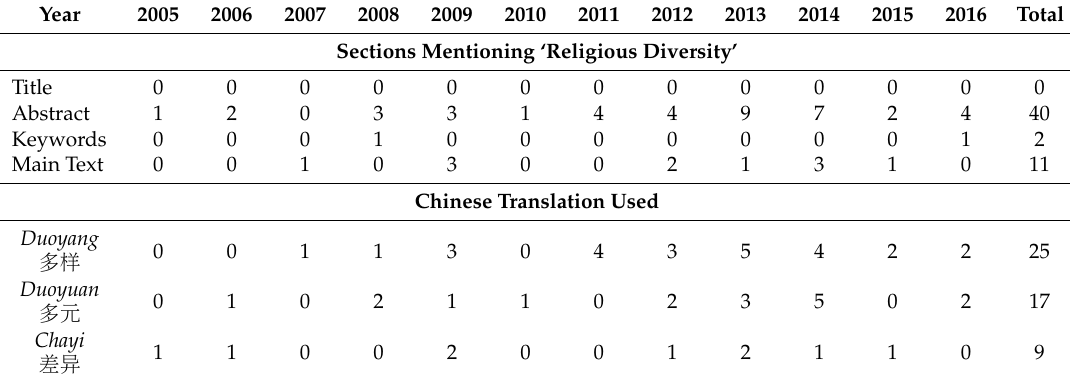
Table 1. Descriptive Statistics for the Usage of the English Phrase ‘Religious Diversity’ in Chinese Dissertations (2005–2016).